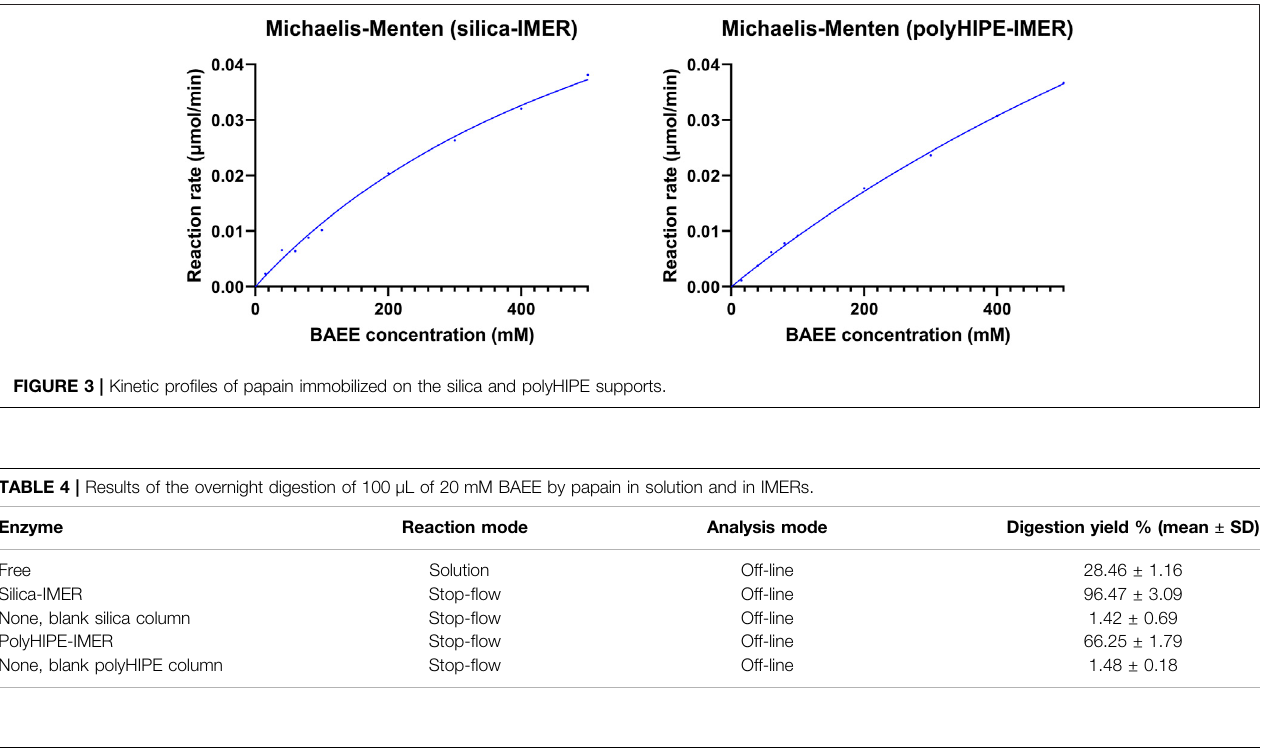
TABLE 5 | Results of the overnight digestion of 20 (on-line) or 100 µl (off-line) of 0.5 mg/ml RTX by papain in solution or in silica- and polyHIPE-IMERs. Results for the silica- IMERs derive from the two different bioreactors (1 and 2) obtained using this